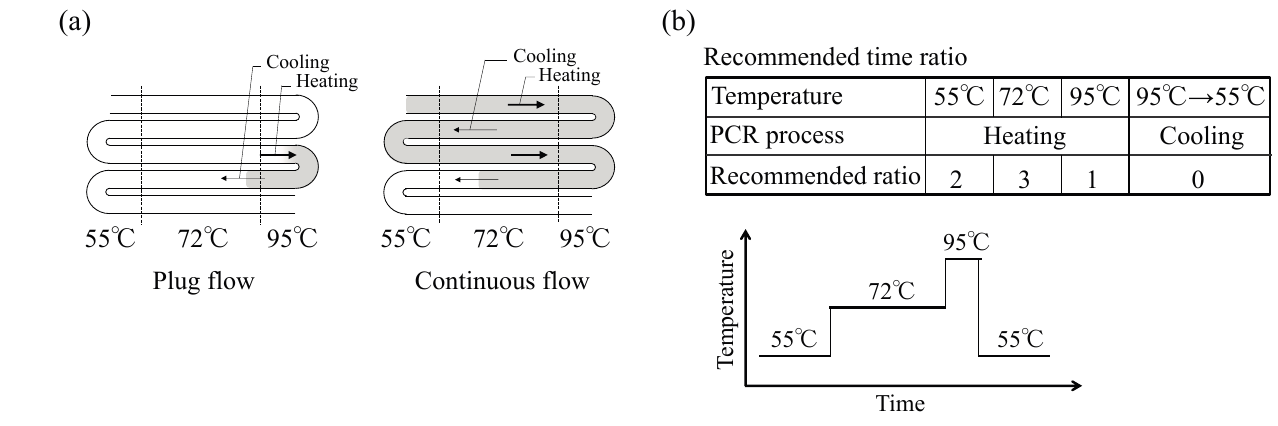
Figure 2. Methodology for flow-through PCR using a microfluidics system: ( a ) Liquid plug-flow and continuous flow; ( b ) Recommended time profile for